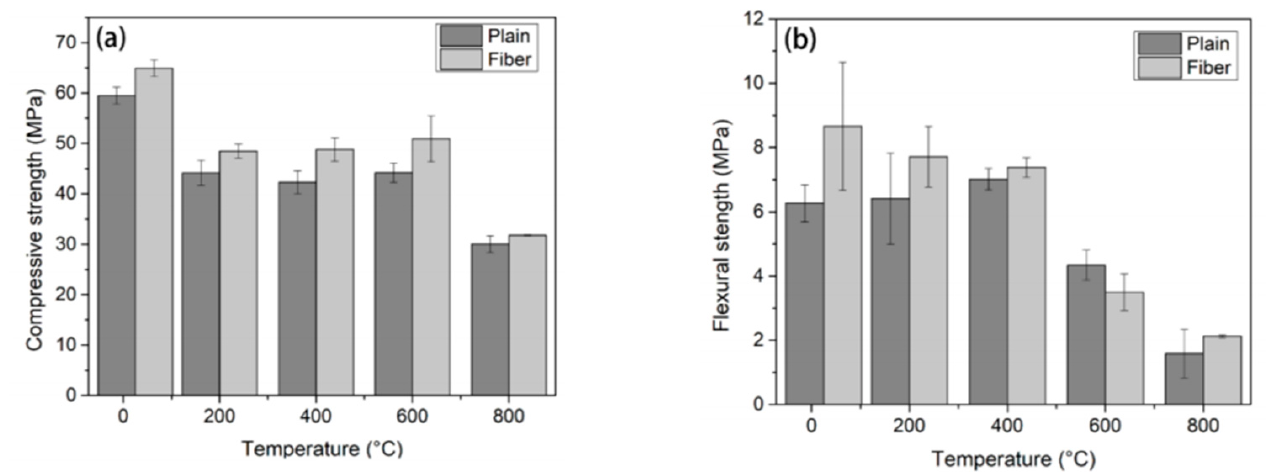
Figure 10. Mechanical properties at elevated temperature. ( a ) Temperature versus compressive strength. ( b ) Temperature versus flexural strength. Reprinted with permission from ref. [49]. Copyright 2018